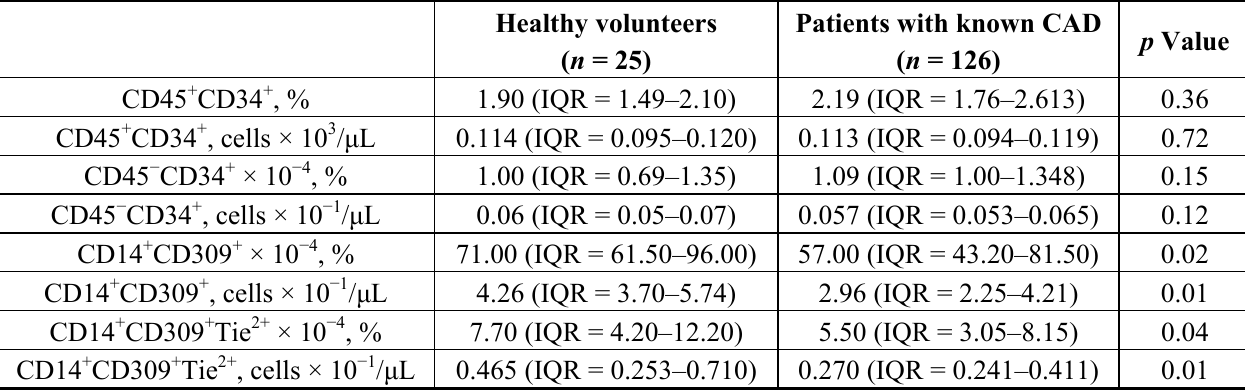
Table 3. Frequencies and absolute values of circulating mononuclear cells in the study patient population.